Question: Generate an informative caption for the figure above.
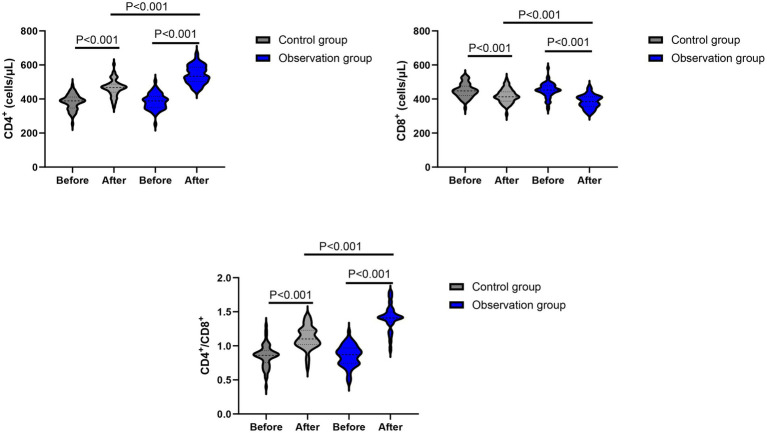
Answer: Immune-function indicators before and after treatment in the two groups. CD4+ and CD8+ T-cell counts are presented as mean ± standard deviation; the CD4+/CD8+ ratio is presented as median (interquartile range).